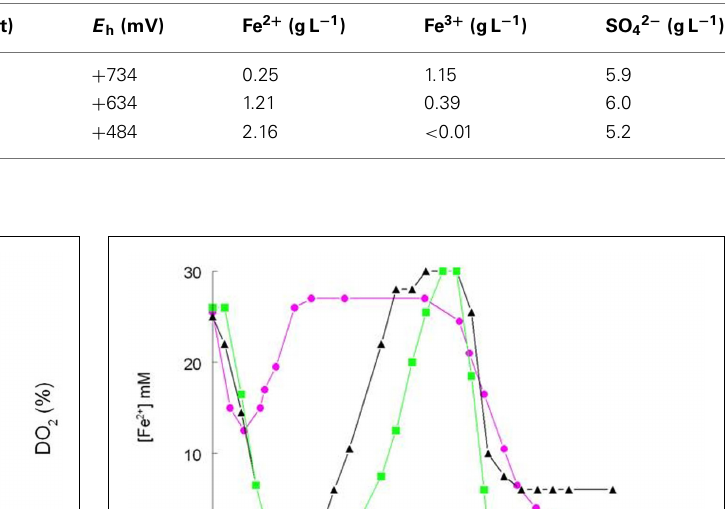
Table 7 | Depth-related chemical changes in acid streamer growths found within the abandoned Cae Coch pyrite mine.